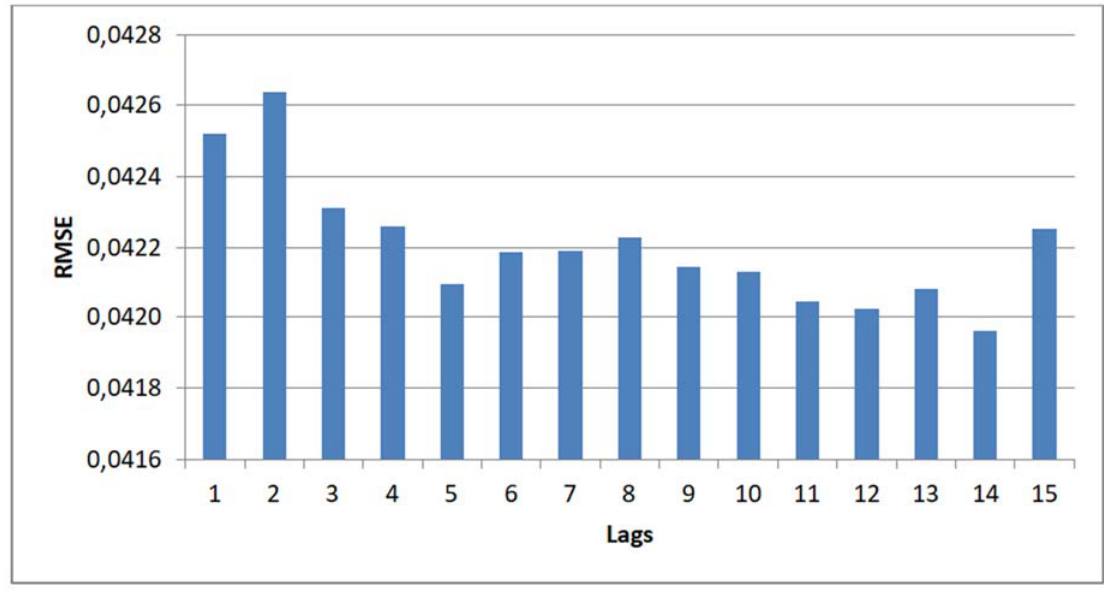
Figure 4. RMSE for AR